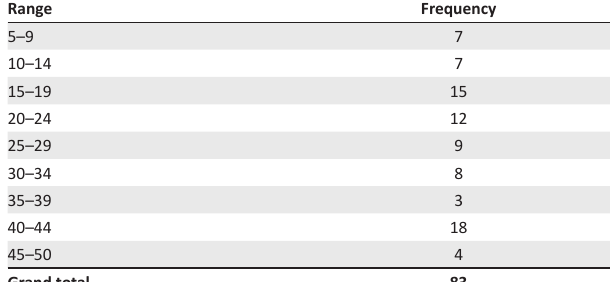
TABLE 3: Number of employees.